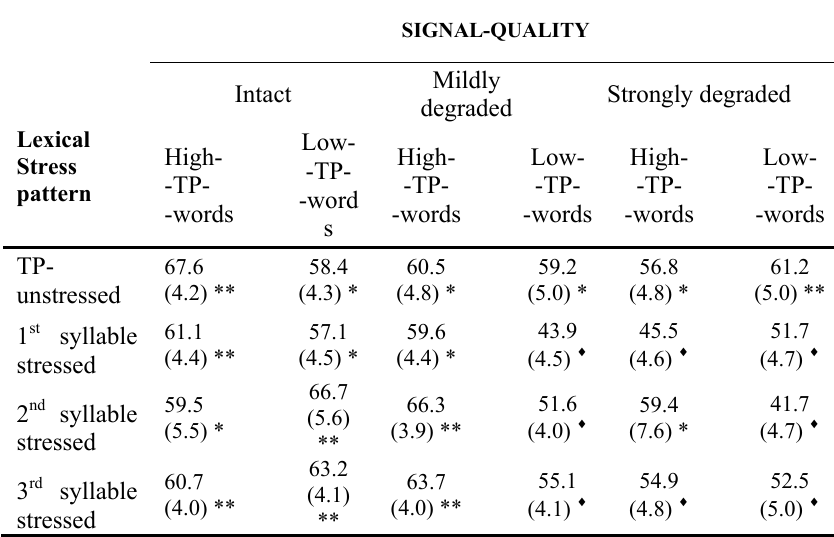
Table 3: Experiment 2B: Mean TP-words choices (in percentage) for both low-TP- -words and high-TP-words for each condition considering signal-quality and lexical stress pattern. Standard errors of the mean in each condition are presented in